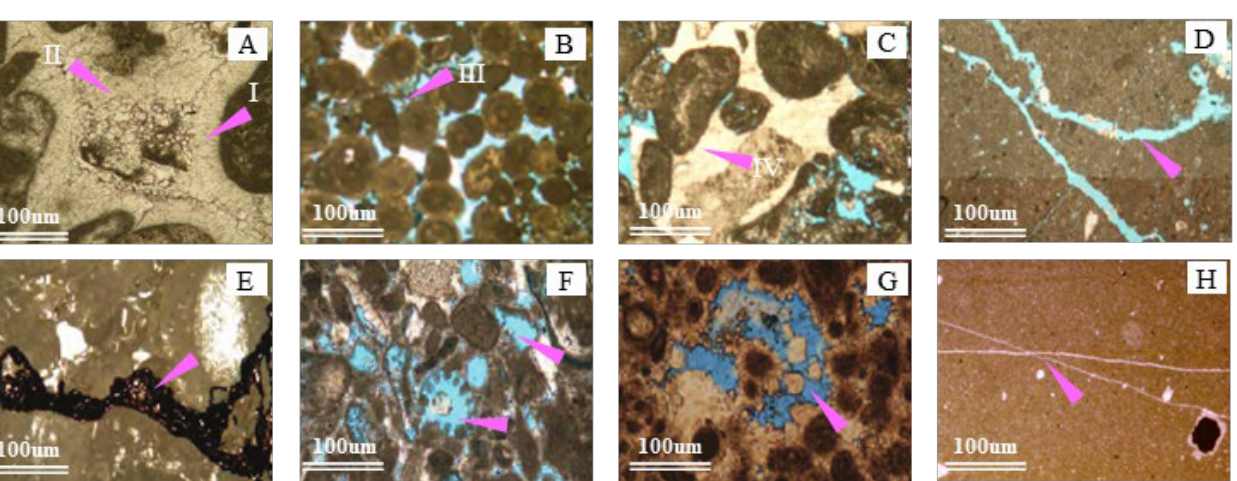
Figure 4. Photomicrographs of diagenetic features of the Callovian-Oxfordian stage. (( A – C ) refer to cementation, where I is isopachous calcite cementation, II is equigranular calcite cementation, III is medium-coarse calcite filling, and IV is intergrowth calcite filling; ( D ) is the fracture formed by mechanical compaction; ( E ) is the stylolite formed by chemical compaction; ( F ) indicates mold pores, intragranular dissolution pores, and intergranular dissolution pores formed by dissolution; ( G ) refers to intergranular and intragranular dissolution pore; ( H ) refers to the shear fracture formed by fracturing).